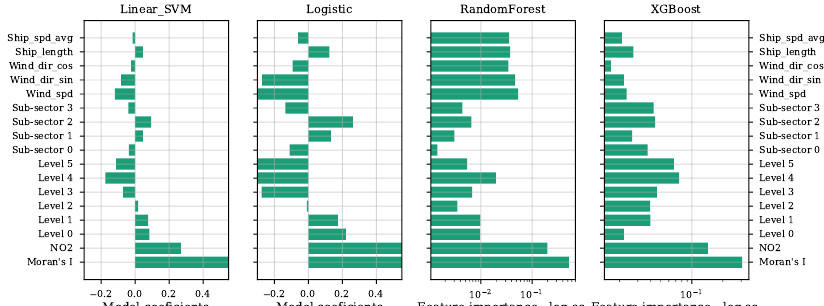
Figure 13. Coefficients of the features in the decision function of the linear models and the impurity- based feature importance values for tree-based models.